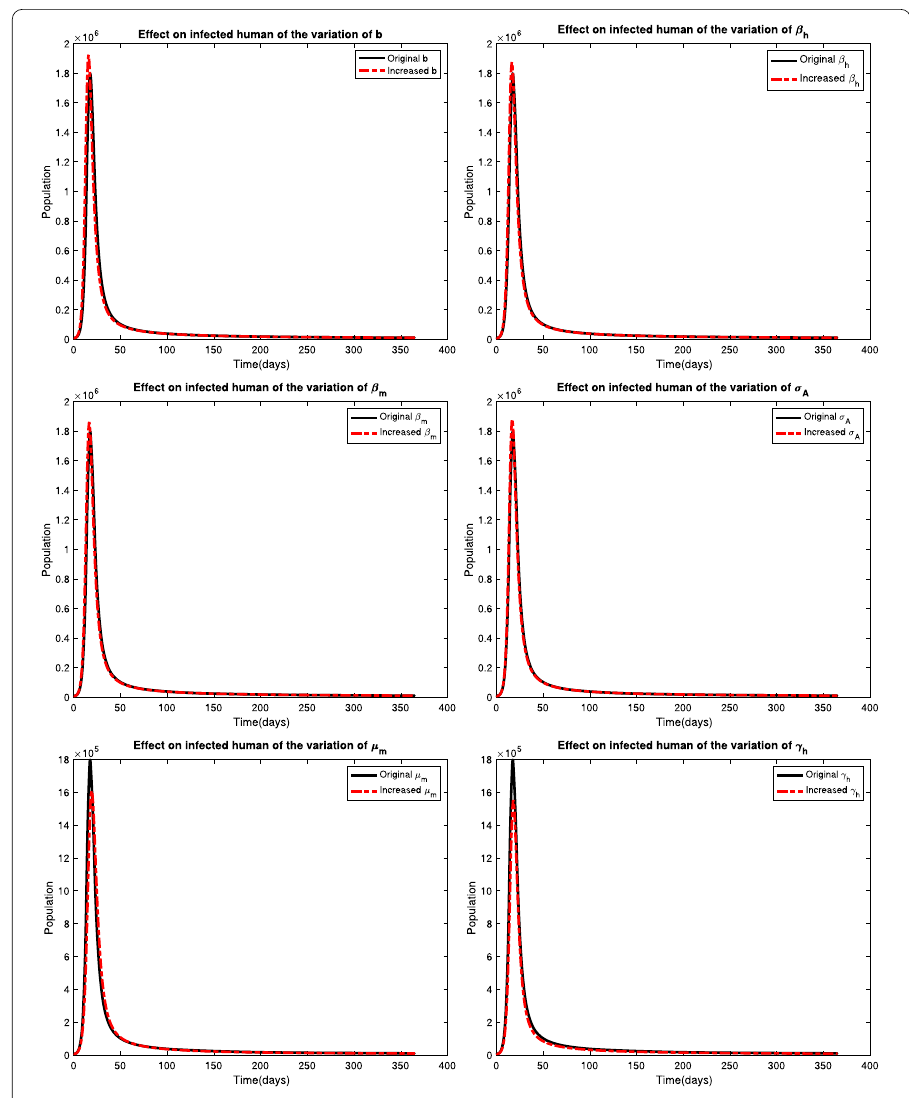
Figure 5 Infected human population with the initial parameter value (solid line) and with an increase of 10% of a specific parameter (dashed